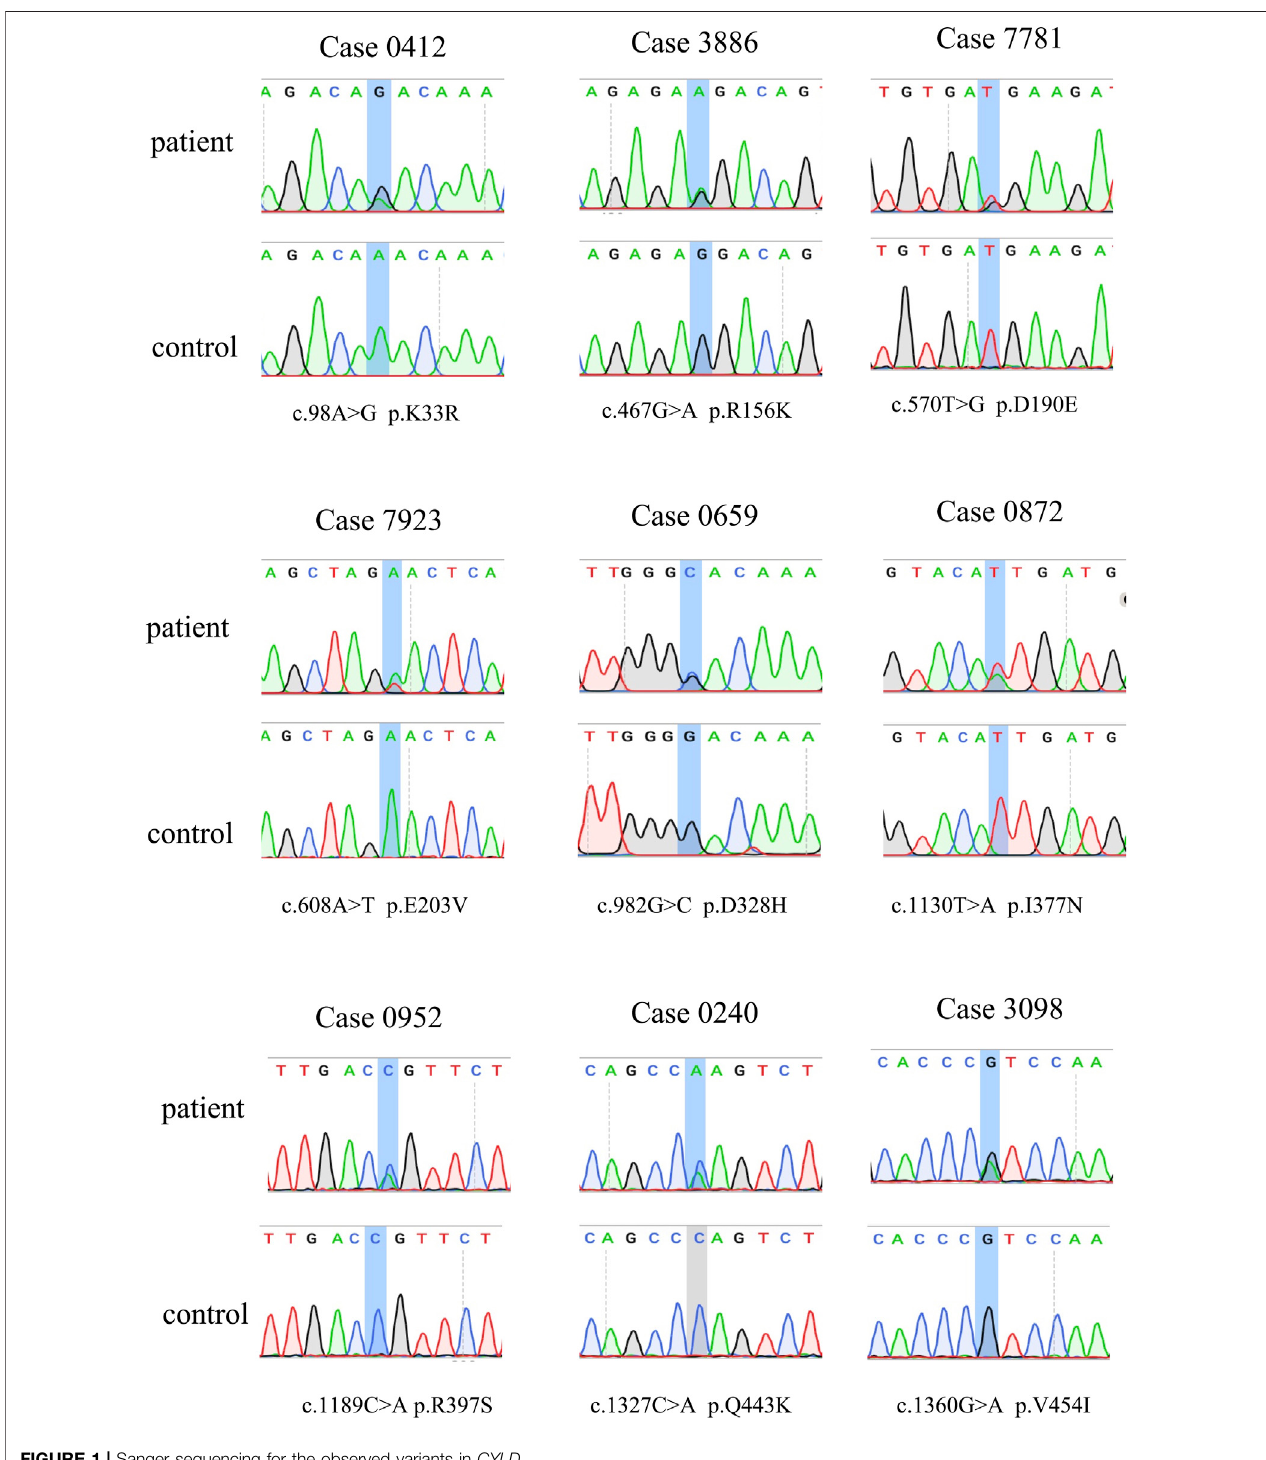
FIGURE 1 | Sanger sequencing for the observed variants in CYLD